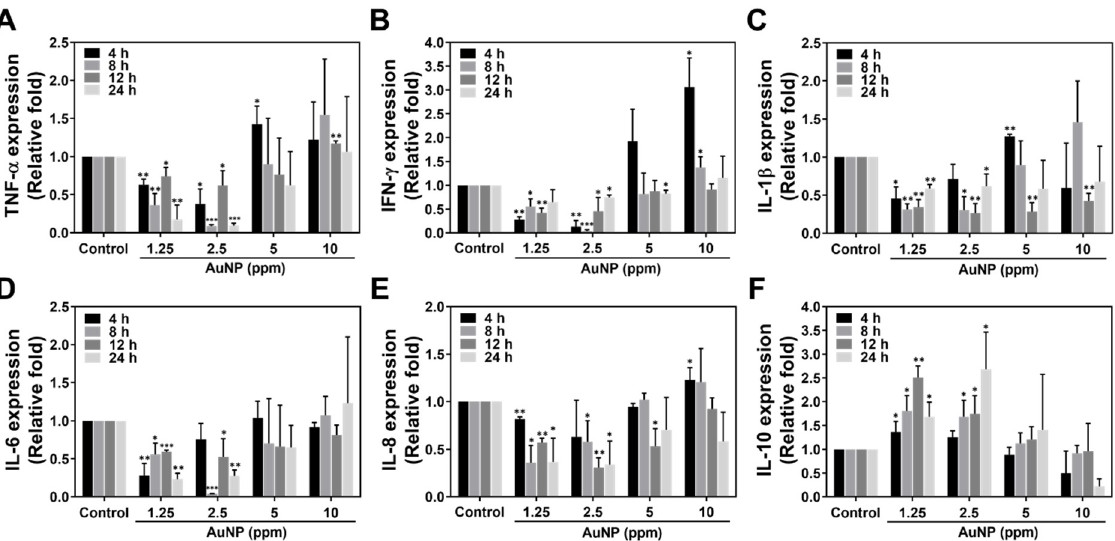
Figure 9. Expressed mRNA for inflammatory cytokines in MSCs. The mRNA expression of inflammatory-related cytokines: ( A ) TNF- α , ( B ) IFN- γ , ( C ) IL-1 β , ( D ) IL-6, ( E ) IL-8 and ( F ) IL-10 were analyzed with real-time PCR assay at 4, 8, 12 and 24 h. In accordance with the semi-quantitative results, the expressed mRNA of TNF- α , IFN- γ , IL-1 β , IL-6 and IL-8 inflammatory cytokines was significantly lower in the 1.25 and 2.5 ppm AuNP treatments. Moreover, the anti-inflammatory cytokine IL-10 was explored to be remarkably higher expressed in MSCs in both 1.25 and 2.5 ppm AuNP groups. The mRNA expression level was quantified as mean ± SD ( n = 3). * p < 0.05, ** p < 0.01, *** p < 0.001: compared to the Control group (TCPS).